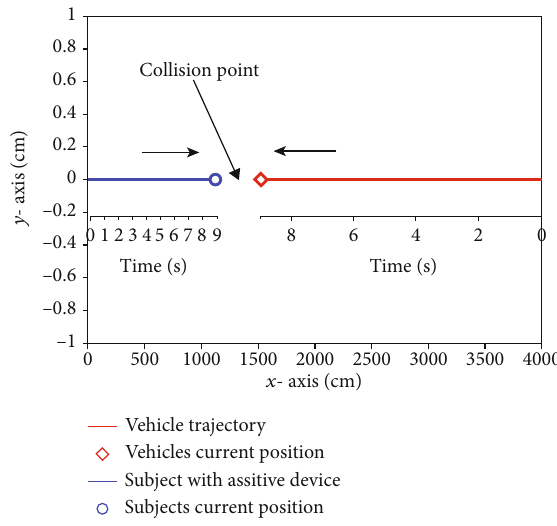
Figure 11: Collision trajectory of the moving object and subject with proposed